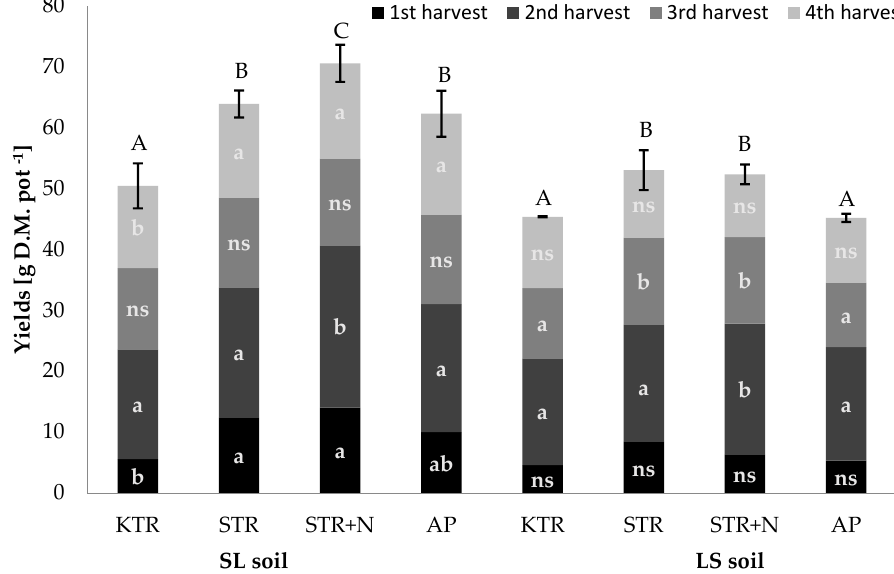
Figure 1. Yields (D.M.—Dry Matter) of grass (sum of four harvests) on the two types of soil: silty loam (SL) and loamy sand (LS). Values followed by the same letters (a–b: for every harvest: 1st–4th, and A–C for sum of four harvests—separately for soils: SL and LS) are not statistically different ( p < 0.05); ns: not significant. The standard deviation within each treatment (n = 3) is indicated by the line extending from the column.